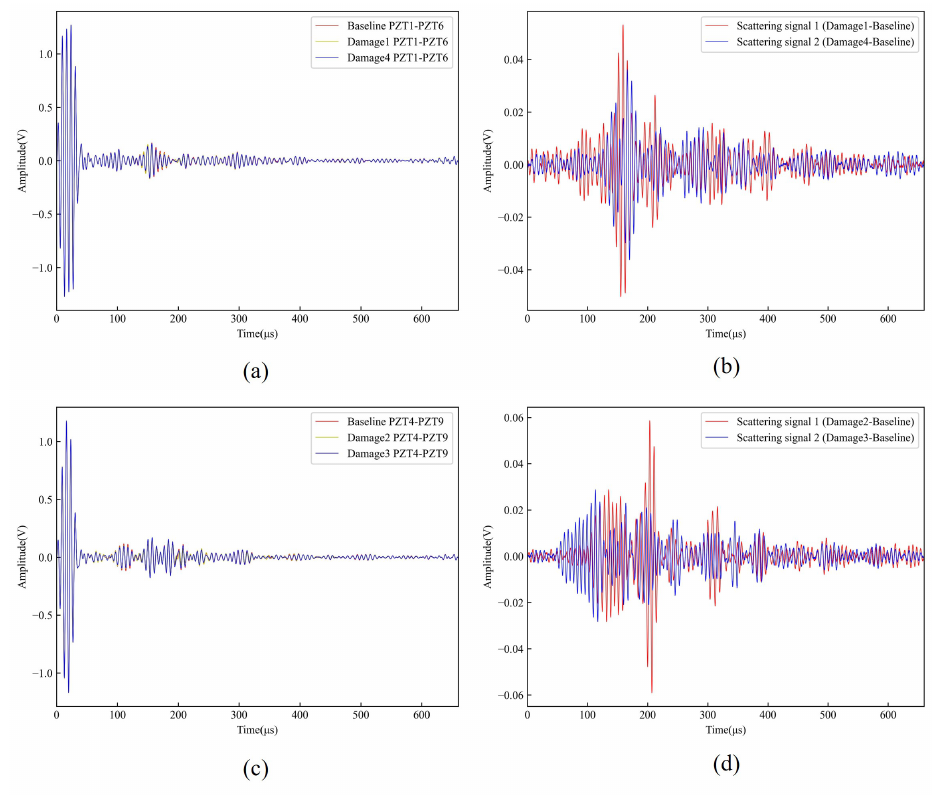
Figure 8. ( a ) Baseline wave signal and damage signals transmitted by PZT1 and received by PZT6; ( b ) Scattering signals corresponding to damage 1 and damage 4; ( c ) Baseline wave signal and damage signals transmitted by PZT4 and received by PZT9; ( d ) Scattering signals corresponding to damage 2 and damage